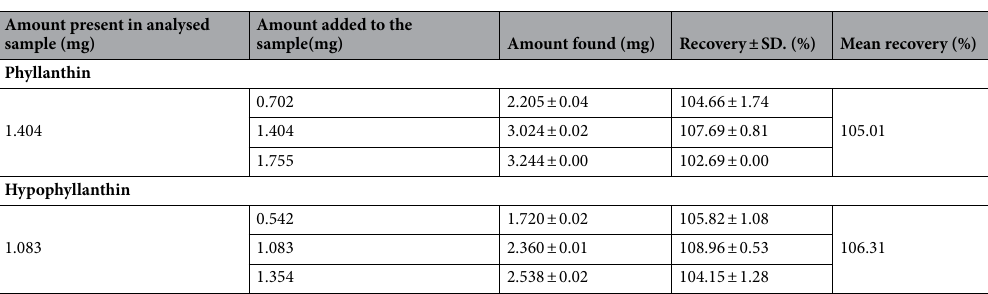
Amount present in analysed sample (mg)